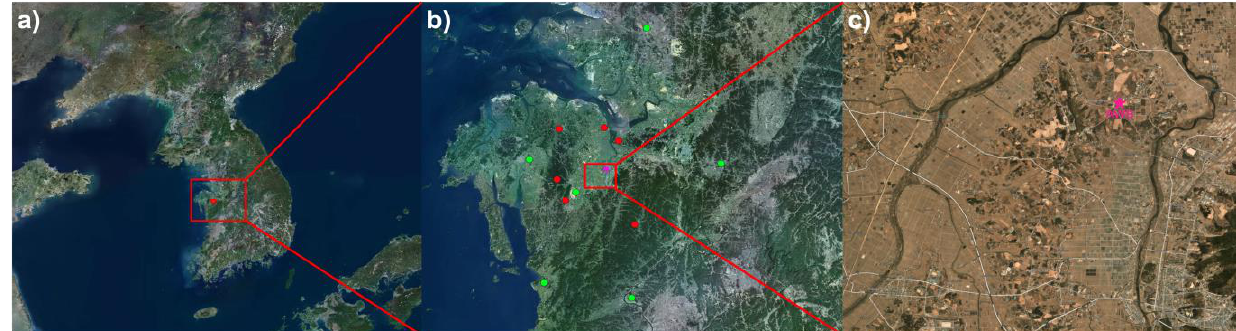
Figure 1. ( a ) Satellite image of Korea provided by KakaoMap. ( b ) Weather station sites of the Korea Meteorological Ad- ministration (red circles: automatic weather station, green circles: Automated Synoptic Observing System, pink star: Yesan weather station). ( c ) Satellite image of study area in April 2020, provided by Planet Lab, and location of weather station (pink star).